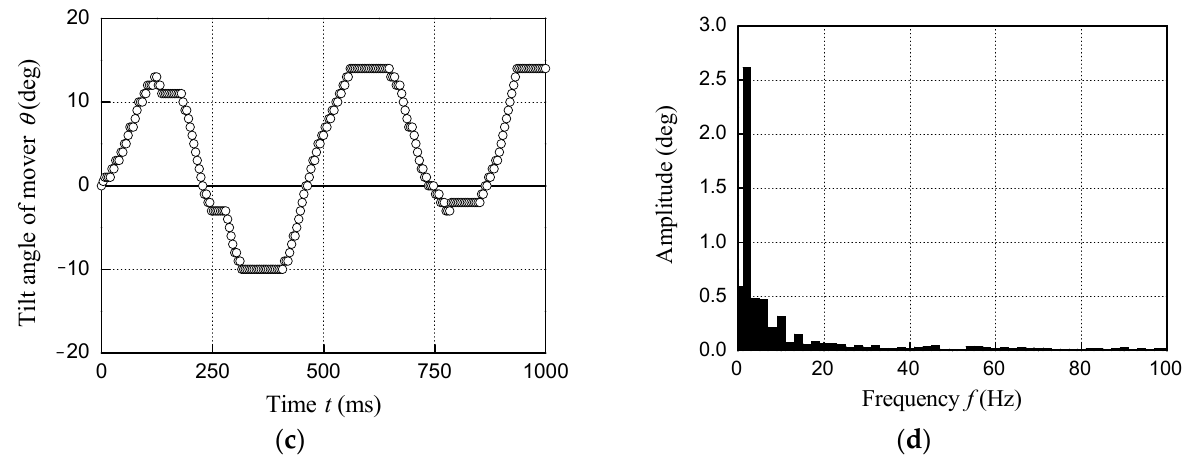
Figure 6. Experimental setup with the proposed generator on the bicycle. ( a ) Mounting position; ( b ) Definition of tilt angle; ( c ) Tilt angle of mover; ( d ) Frequency component of tilt angle. Acceleration measurement results indicated that irregular vibrations occurred in the moving bicycle. The generator extracted only the vibrations in a specific low-frequency range in the horizontal direction from a wide vibration range. Bicycle vibrations generated a liquid wave of a particular frequency, which made the tilt angle of the mover